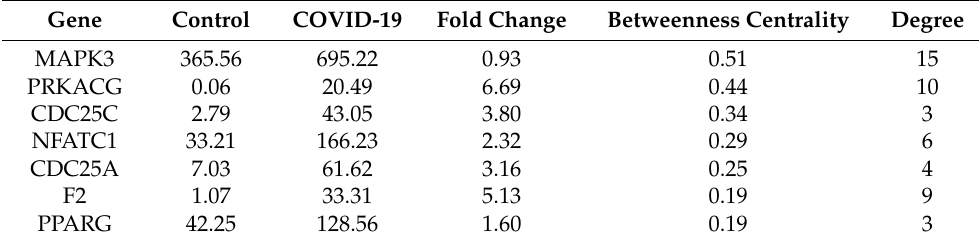
Table 1. DEGs with betweenness centrality outer than 95% after z-score normalization.